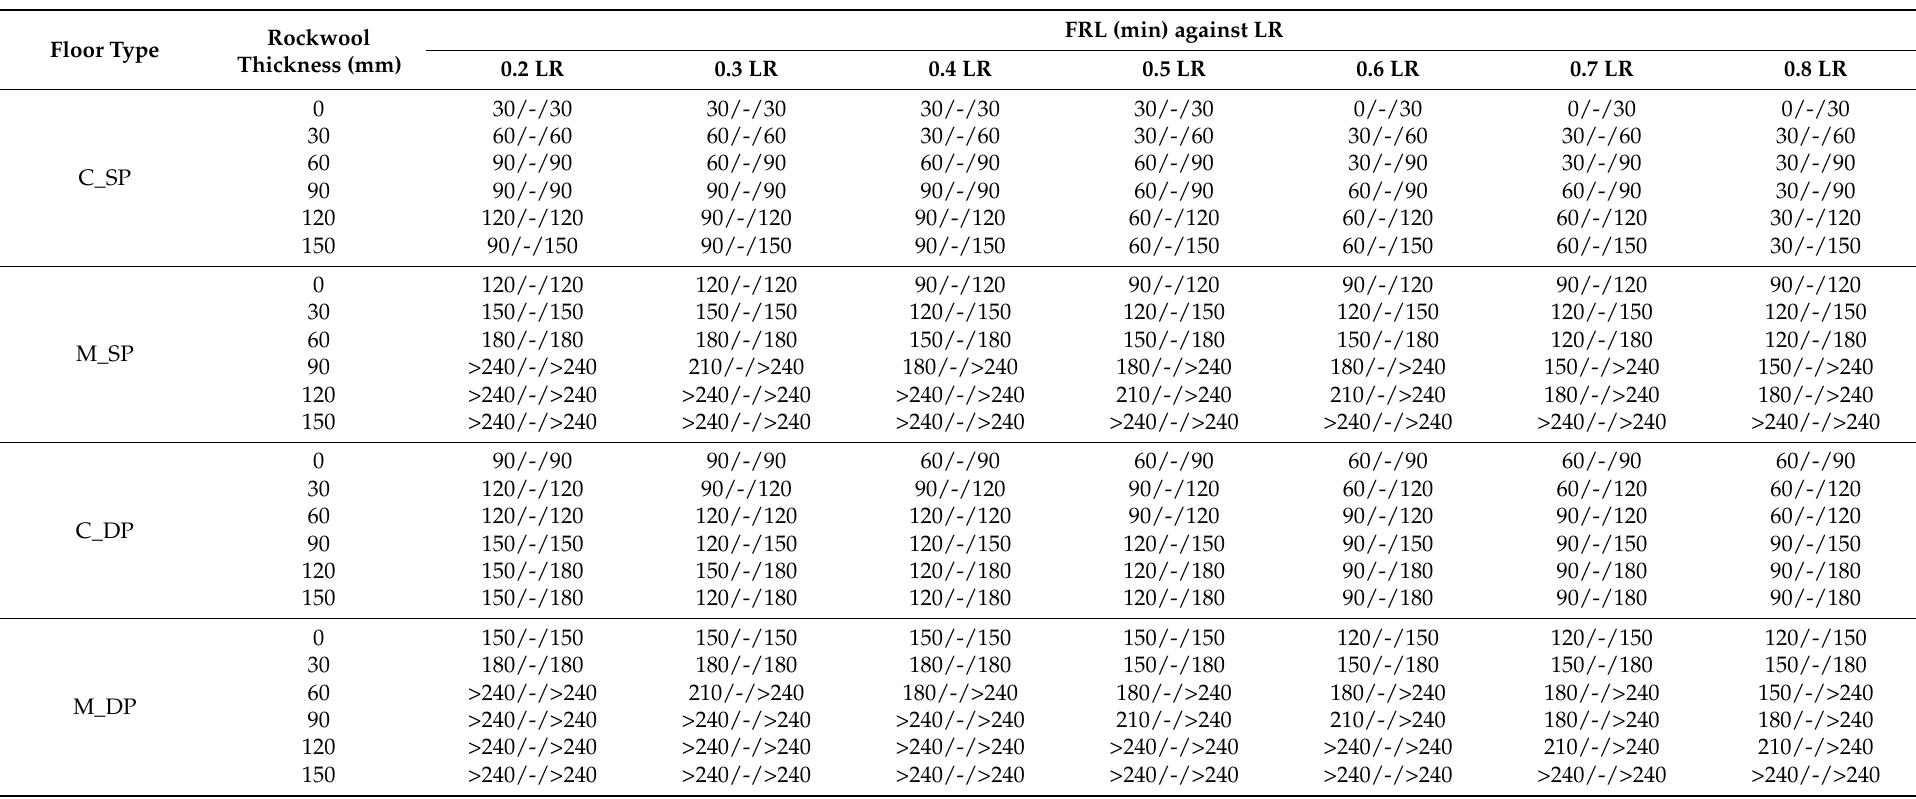
Table 4. FLRs of parametric floor systems specified in accordance with the industry